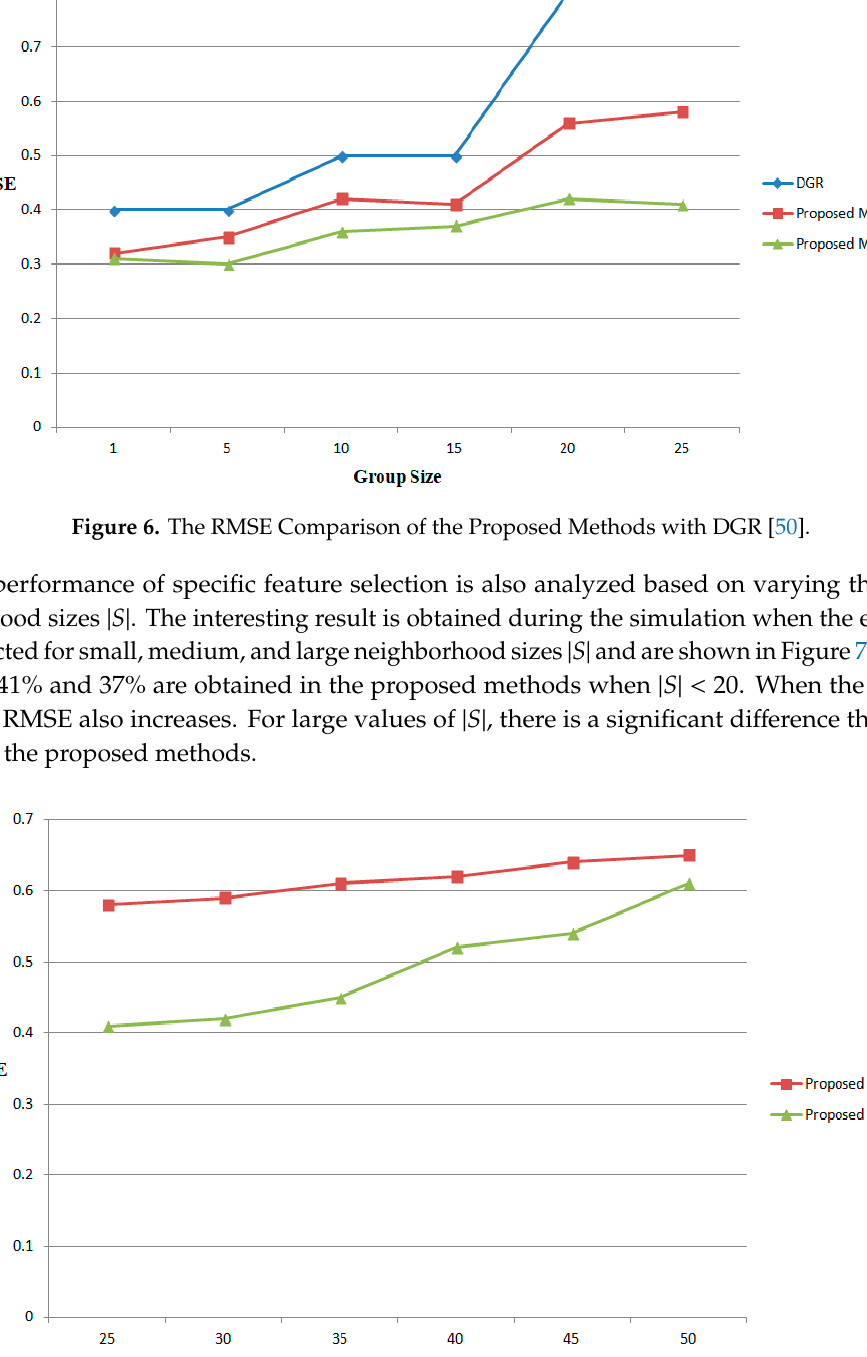
ff erent Neighborhood